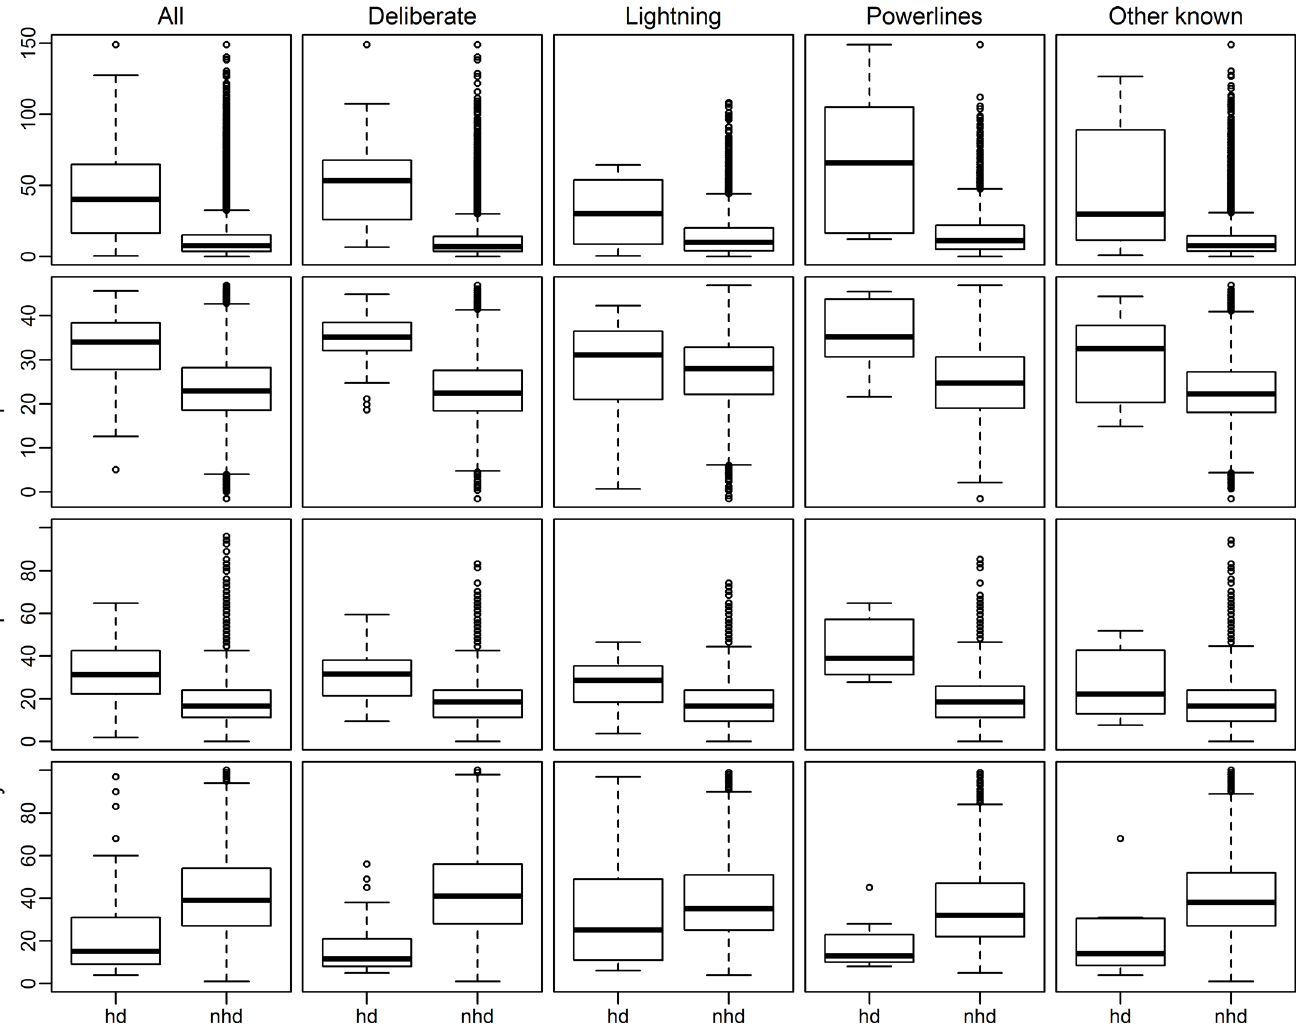
Fig 4. Box plots for ignition causes of wildfires that destroyed houses and wildfires where no houses were destroyed for the 12 years with complementary data for fire weather elements. Forest Fire Danger Index (FFDI), hd = wildfires that destroyed houses, nhd = wildfires where no houses were destroyed, All = all ignition causes including undetermined